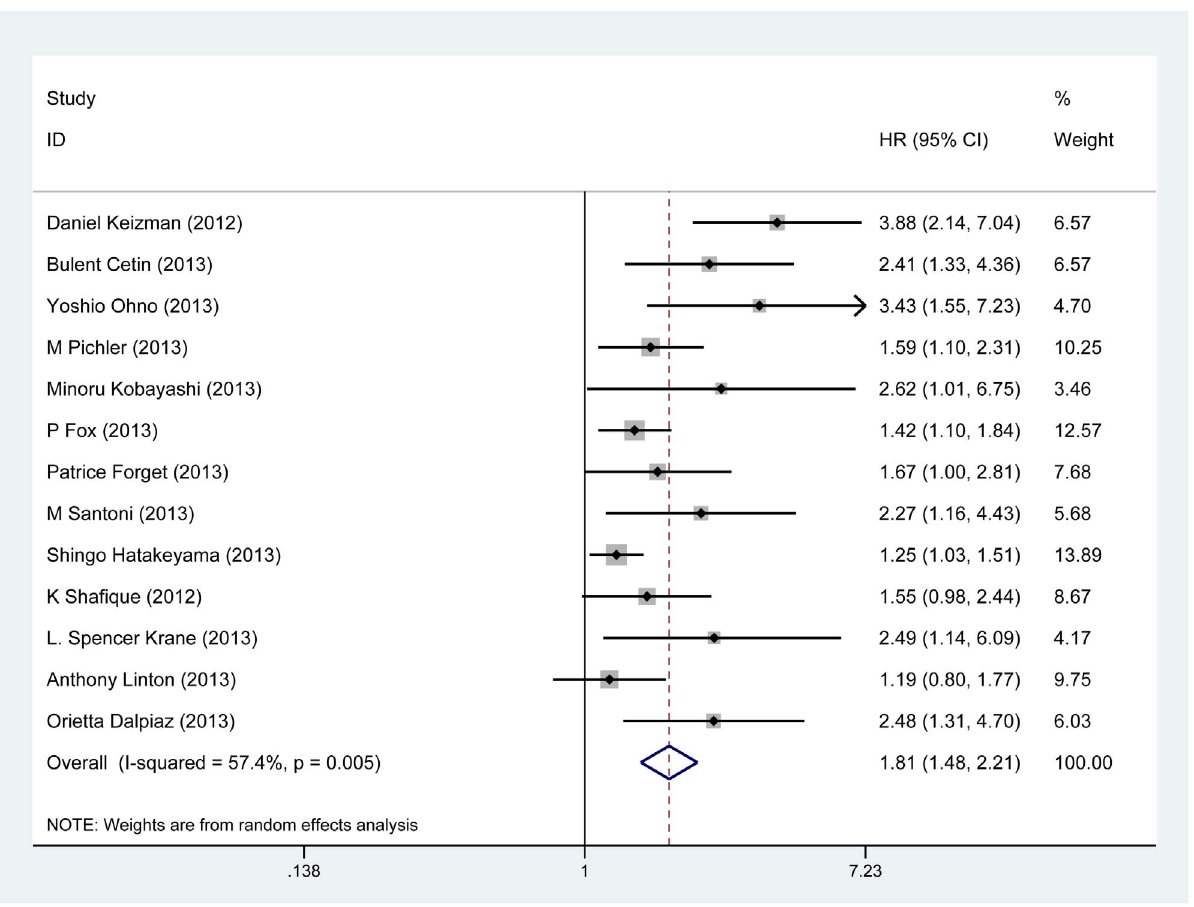
Figure 2. Forrest plots of studies evaluating hazard ratios (HRs) of NLR for overall survival.